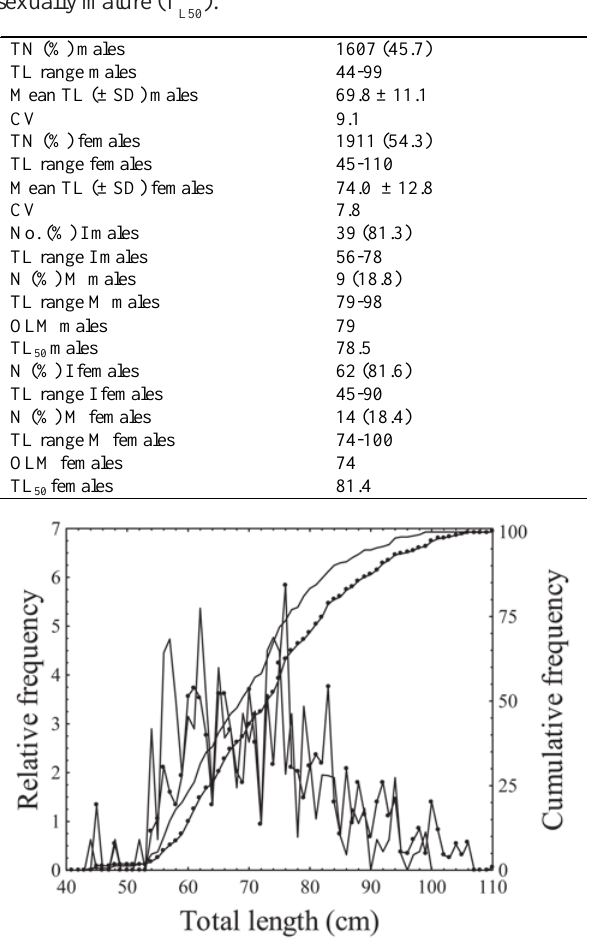
Fig. 2. Relative and cumulative frequency of total length for Dipturus chilensis by sex (males=continuous line; females=line with circles).